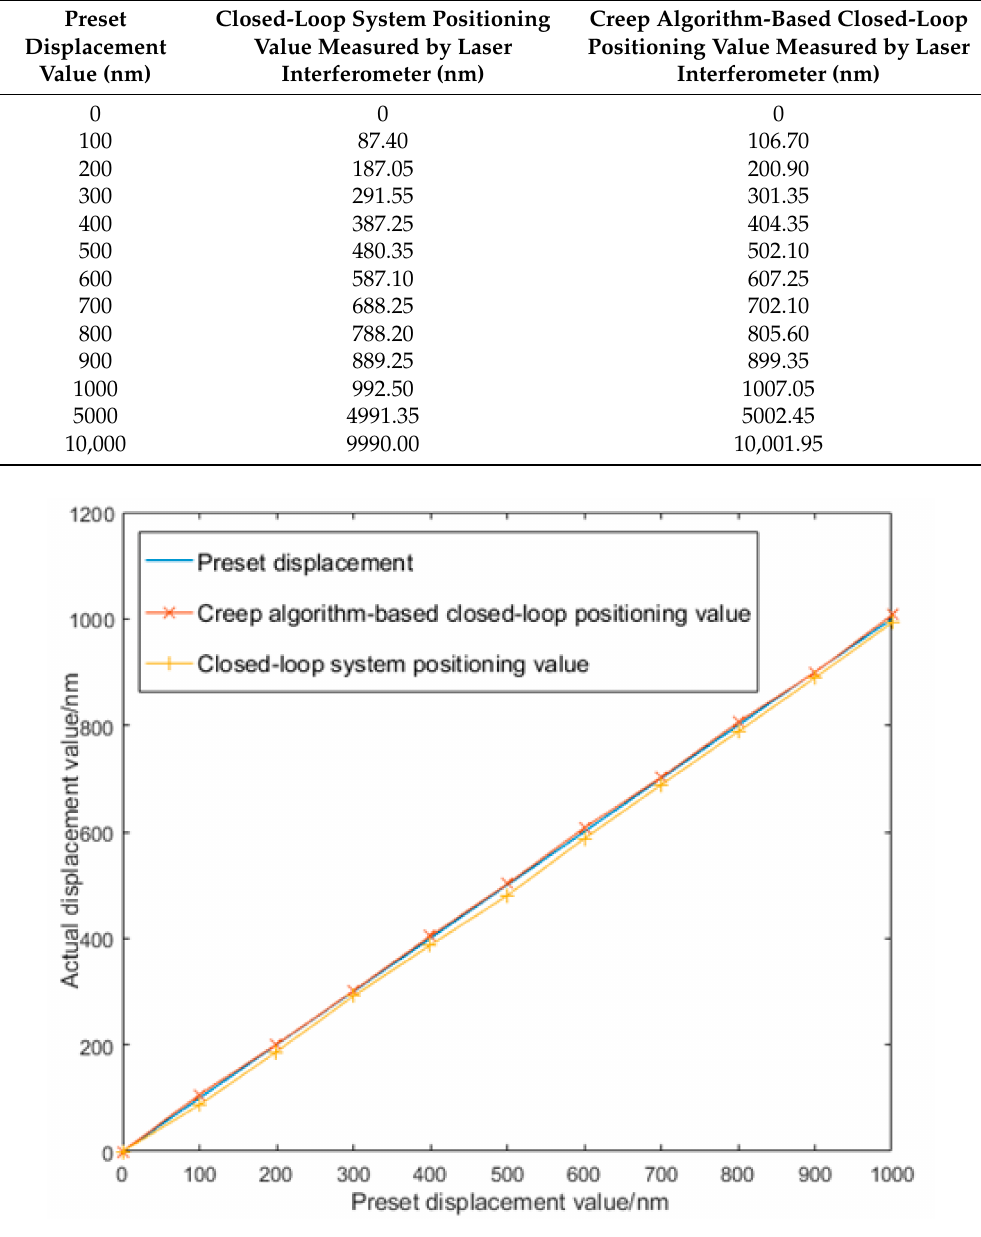
Figure 13. The positioning precision displacement of two algorithms under the